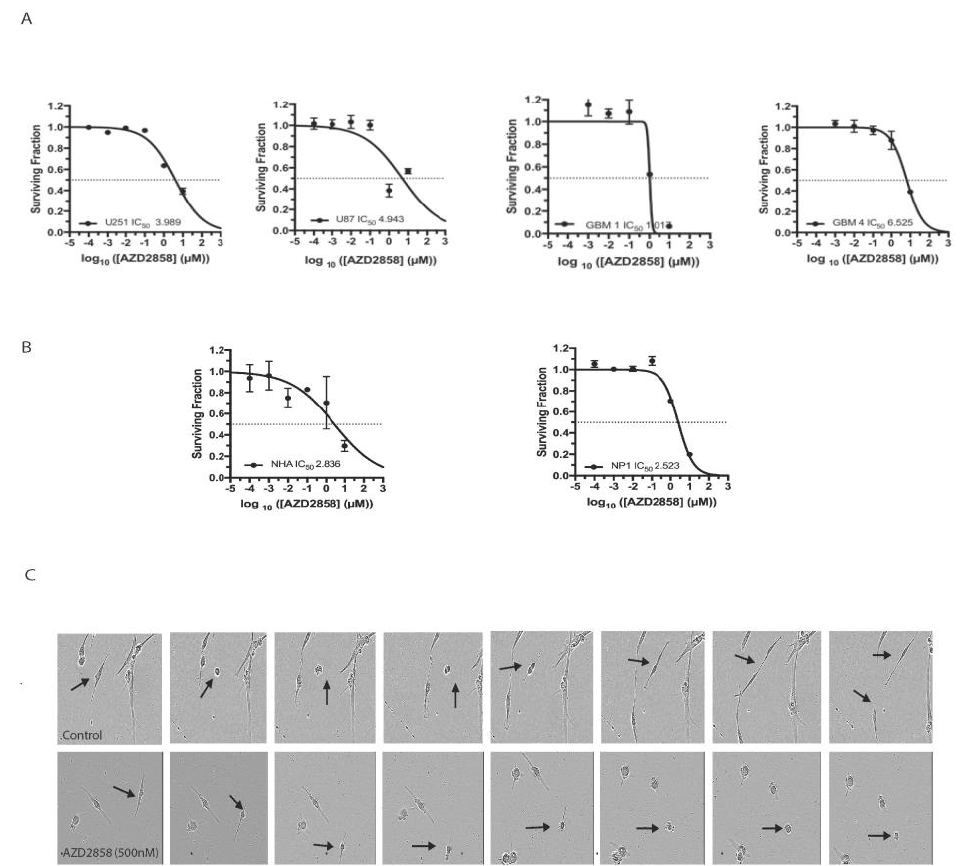
Figure 1. AZD2858 is cytotoxic in glioma cell lines at micromolar concentrations and induces mitotic defects at submicromolar concentrations. ( A ) The established cell lines U251 and U87 and patient-derived glioma stem cell-like cell lines GBM1 and GBM4 were treated with 10-fold dilutions of AZD2858 in triplicate. Cell viability was assessed by MTT at day 3 post treatment. ( B ) Normal brain cells including normal human astrocytes (NHA) and neural progenitor cells (NP1) were treated with 10-fold dilutions of AZD2858 in triplicate. Cell viability was assessed by MTT at day 3 post treatment. ( C ) The established cell lines U87 and U251 and the patient-derived glioma stem cell-like cell line GBM4 were treated with 1 µ M or a concentration range (0.01–1 µ M) of AZD2858 and imaged over 72 h or over 1 week by live cell imaging. Representative stills are shown from live cell imaging movies of the patient-derived stem cell-like cell line GBM4 mock-treated with DMSO (top panel) or treated with AZD2858 at 500 nM. This dose was chosen as no cytotoxic effects were observed on normal progenitor cells or NHA and to illustrate specific effects on mitosis in the GBM cell line. Arrows indicate mitotic cells during the duration of mitosis. Images were taken from AVI movies generated with the Incucyte imaging system. Magnification = 10 ×